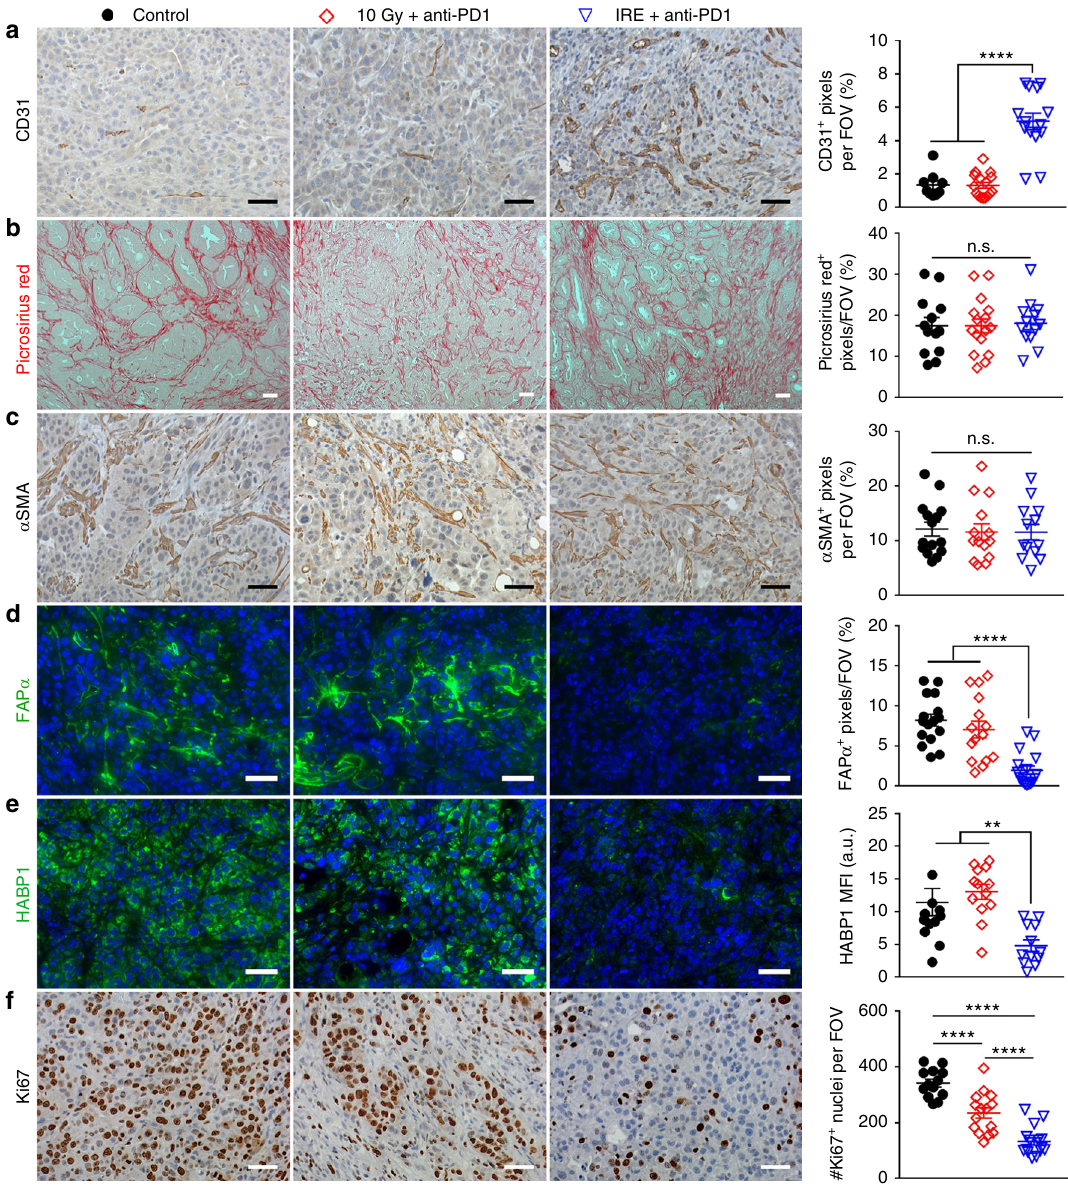
Fig. 9 IHC staining of viable tumor after 10 Gy + anti-PD1 or IRE + anti-PD1. Representative micrographs of staining for CD31 ( a ), Picrosirius Red ( b ), α SMA ( c ), FAP α ( d ), HABP1 ( e ), and Ki67 ( f ) in control (black solid circle), 10 Gy + anti-PD1 (red diamond), and IRE + anti-PD1 (blue triangle) groups, and corresponding quanti fi cations. Ten to fi fteen visual fi elds were randomly captured. Scale bars = 50 µ m. Five doses of anti-PD1 had been administered at this time point for the 10 Gy + anti-PD1 and IRE + anti-PD1 groups. Data are presented as mean ± SEM. Signi fi cance was determined using 1-way ANOVA followed by Tukey post hoc analysis. * p < 0.05, ** p < 0.01, *** p < 0.001, **** p < 0.0001. MFI mean fl uorescence intensity, FOV fi eld of view, n.s. not signi fi cant. Source data are provided as a Source Data fi